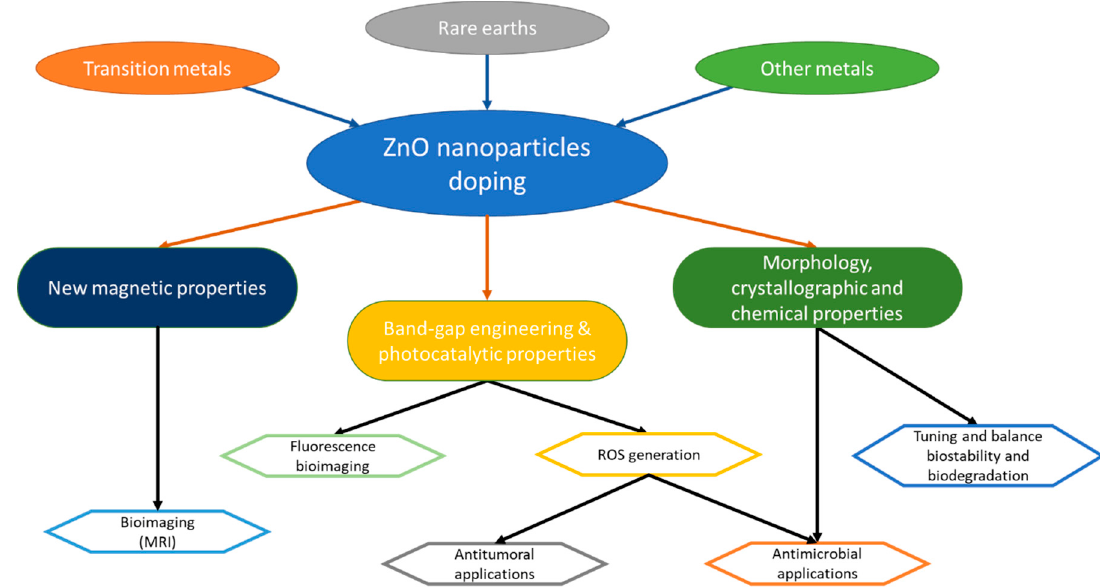
Figure 1. Main applications of doped ZnO nanoparticles in nanomedicine.